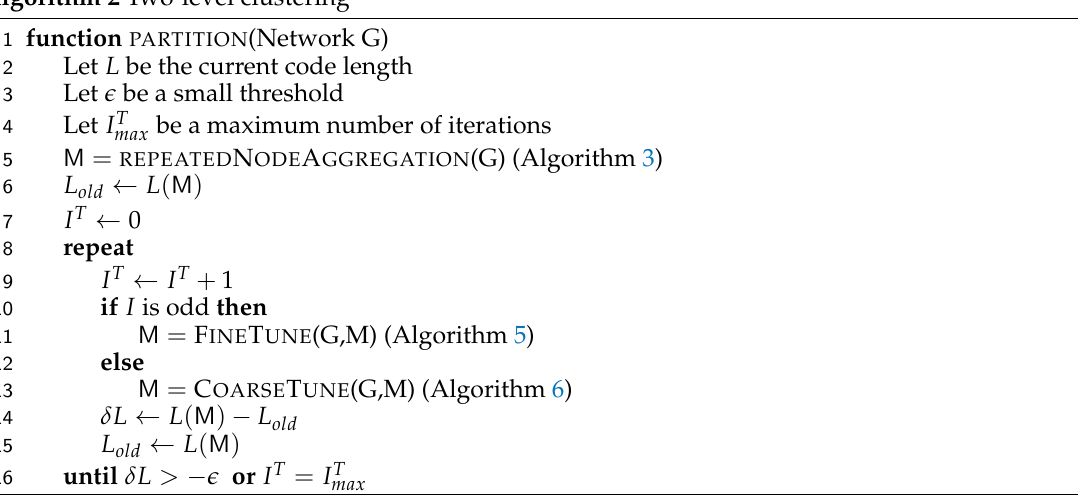
Algorithm 2 Two-level